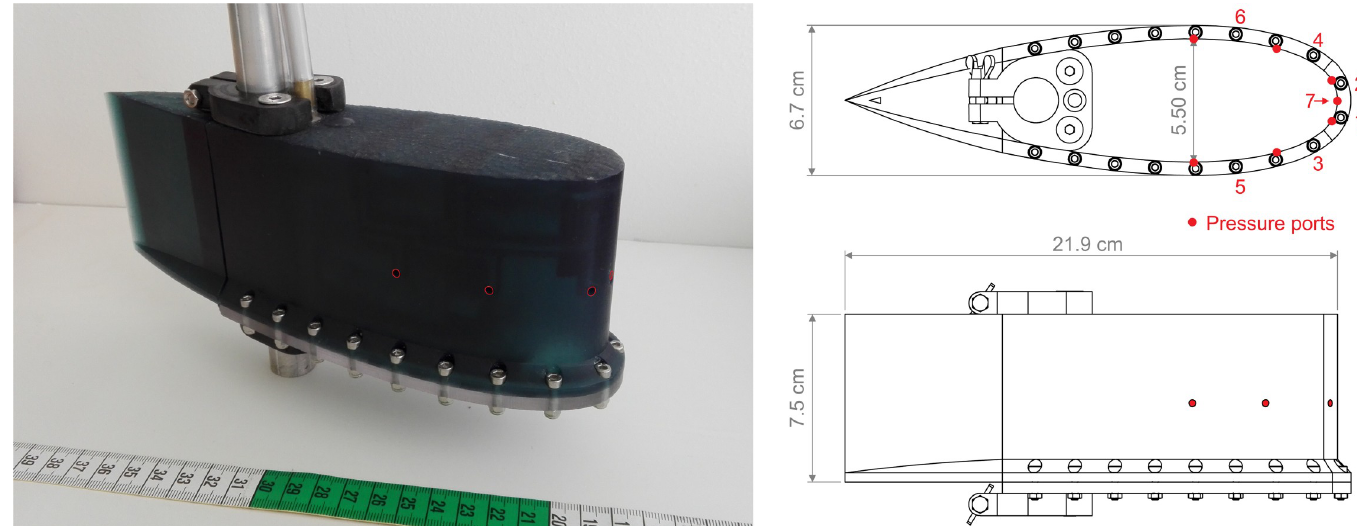
Fig 3. Lateral line probe (LPP). NACA025 body shape, showing the locations of the differential pressure sensors (1–6), and the absolute pressure sensor (7).